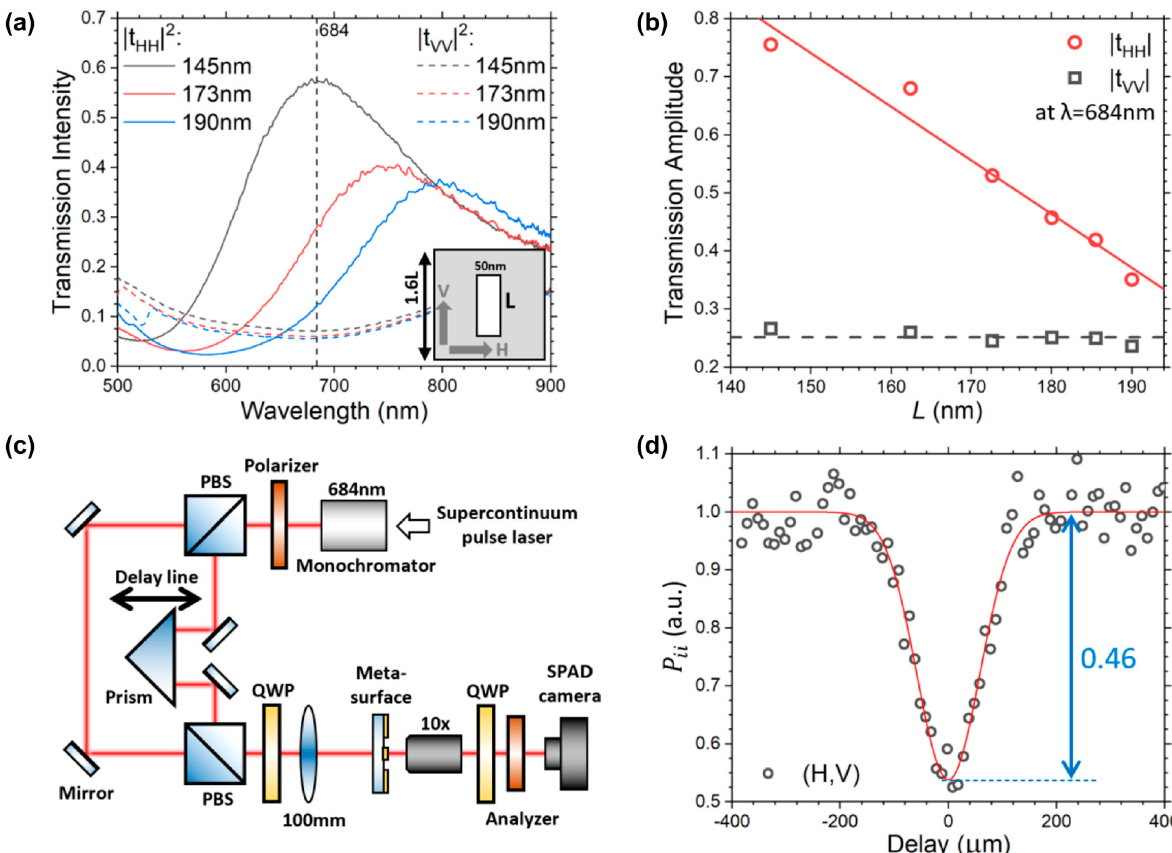
Figure 2: Design parameters of the metasurface and the experimental setup. (a) The measured spectrum of the vertically orientated periodic nanoslot array with slot length L and fixed-width at 50 nm. Inset is the unit cell (1.6 L × 1.6 L ) of the nanoslot array. For L = 145 nm, the nano-slot array acts almost like a horizontal polarizer such that the transmission ratio ( T the working wavelength for our coincidence imaging. (b) Transmission amplitude | t | at wavelength 684 nm of the nano-slot array as a function of L . The red solid line is a linear fit to the horizontal polarization’s data (red circles) while the black dashed line gives the mean value of the vertical polarization’s data (black open squares). The red line provides the amplitude dependence on L for the design of our metasurface. (c) Experimental setup for the coincidence imaging. Two orthogonal circularly polarized (RCP & LCP) pulses are prepared at 684 nm and focused onto the object and also the reference metasurface by a 100 mm lens. The transmitted light is collected by a 10 × objective and projected to LCP, after passing through a quarter waveplate and a polarizer, before being captured by an SPAD camera. (d) Normalized coincidence count between reference’s horizontal (H) and vertical polarizations (V), i.e. P Gaussian fit to the